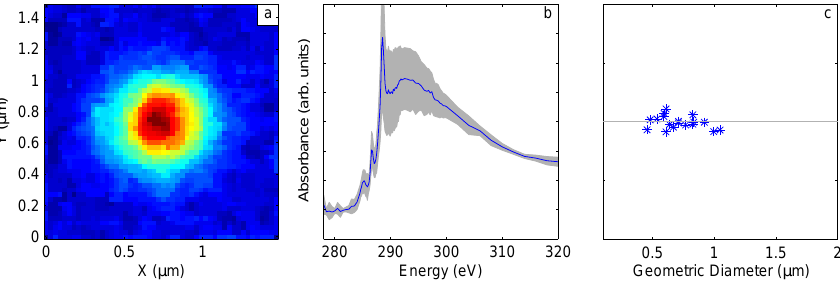
Fig. 3. Images, spectra, and sizes from STXM-NEXAFS analysis. (a) Representative absorbance image at 288 electron volts (eV) for particles with absorption at ketone band (286.7eV). All 18 particles of this type were spherical. (b) Average spectra (blue lines) ± one standard deviations (grey regions). (c) One-dimensional plot showing size and number of particles in used to calculate average and standard deviation of absorbance spectrum (points are randomly jittered along y-axis to minimize overlapping of